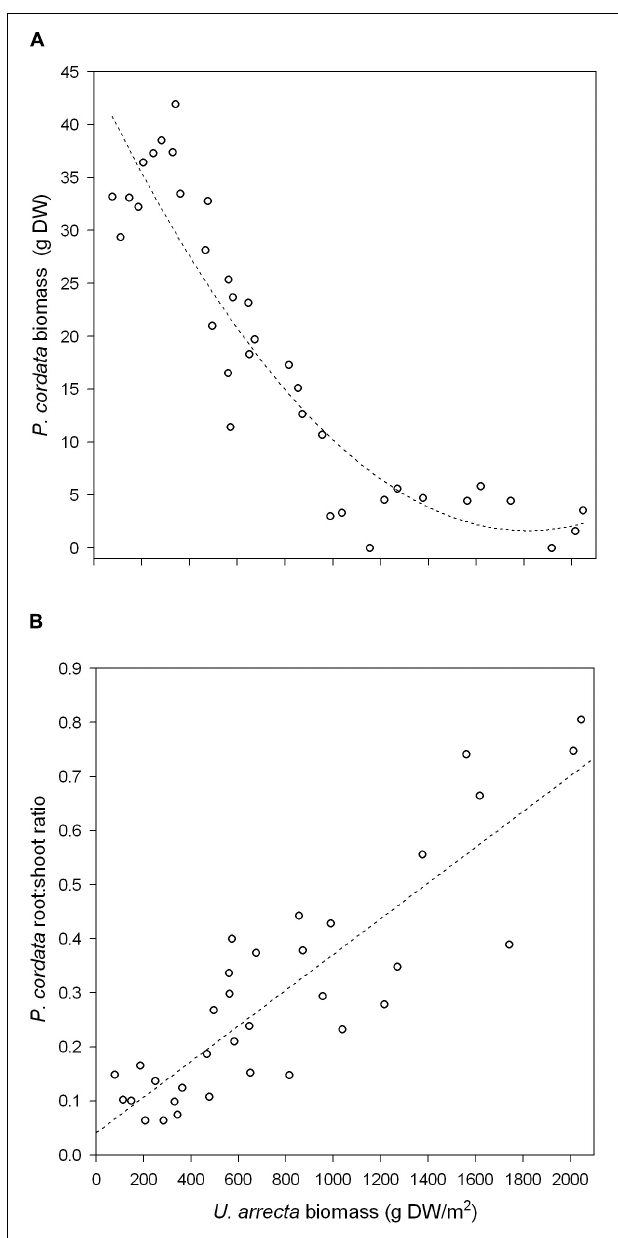
FIGURE 2 | Relationship between the shoot biomass of U. arrecta and the biomass (A) and root:shoot ratio (B) of Pontederia cordata (data from the in situ